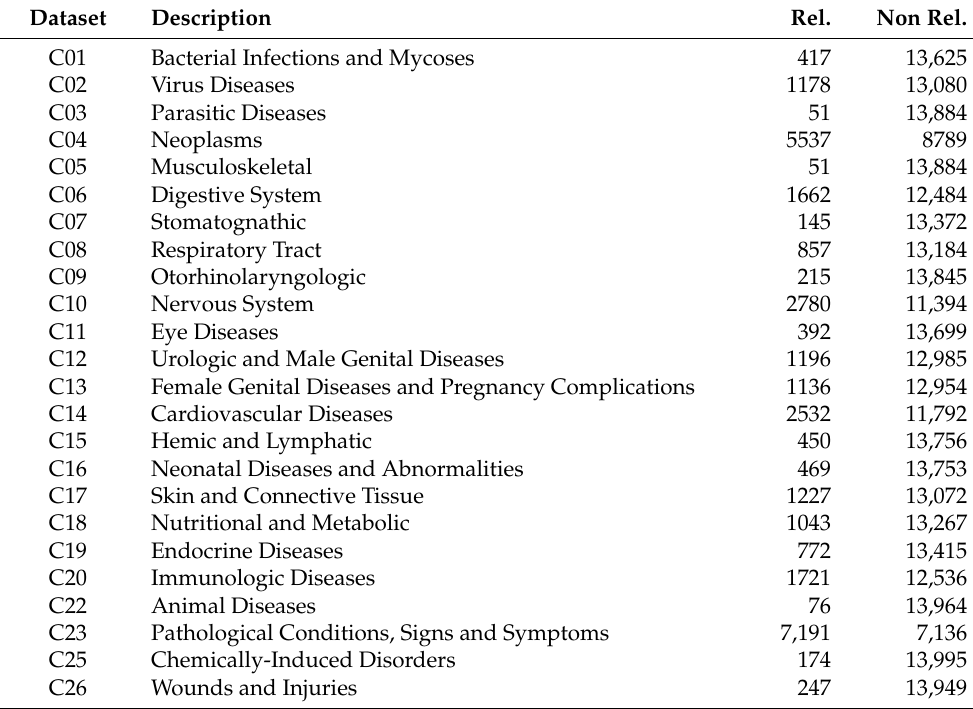
Table 1. Number of relevant and non-relevant documents of OHSUMED that we have assembled for each